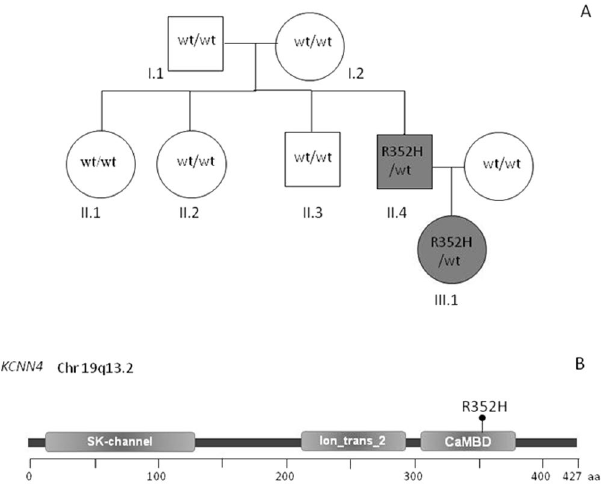
Figure 2. ( A ) Inheritance pattern of the family. ( B ) Schematic representation of KCNN4 protein domains, and position of R352H